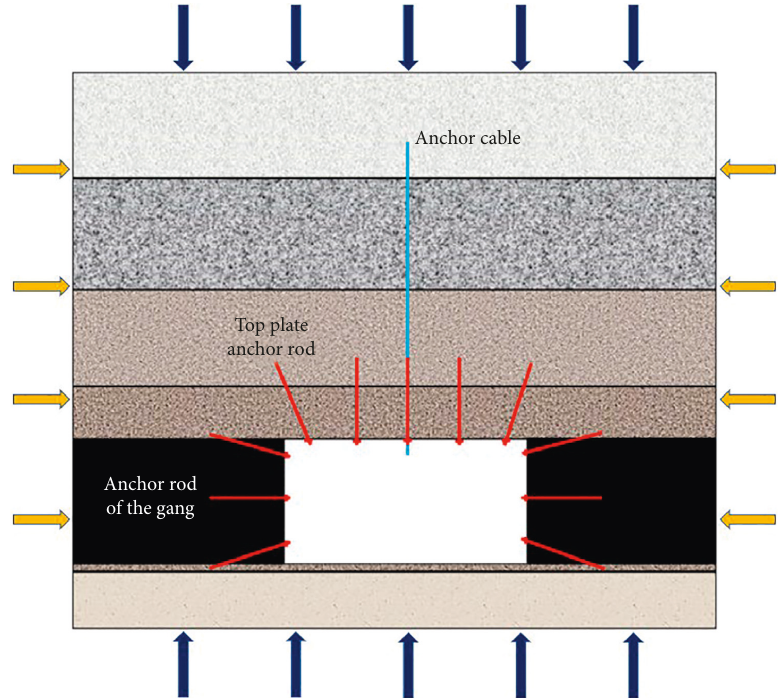
Figure 8: Cross-sectional view of roadway